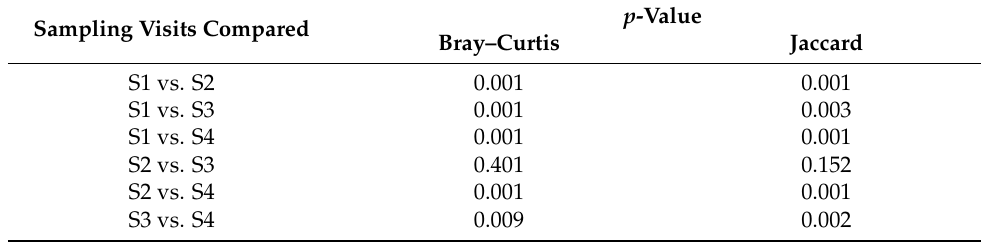
(Table 2; Figure 2a,b). Diversity comparisons between the group of samples positive and neg- ative for L. monocytogenes showed no difference (Figure 2c,d).